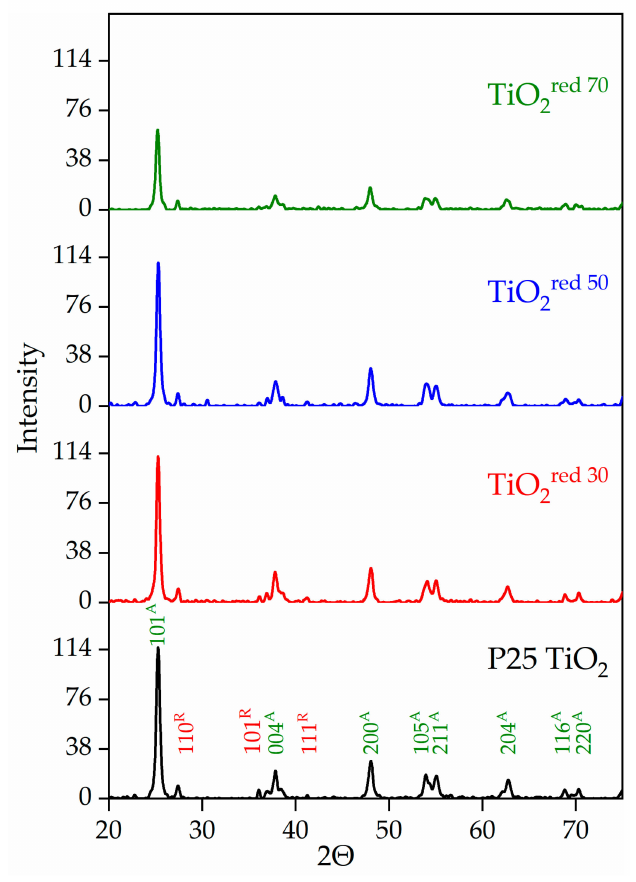
Figure 3. Comparison of XRD patterns among P25 TiO 2 and reduced forms of P25 TiO 2 materials (green and red Millar indices represent the anatase and rutile phases,